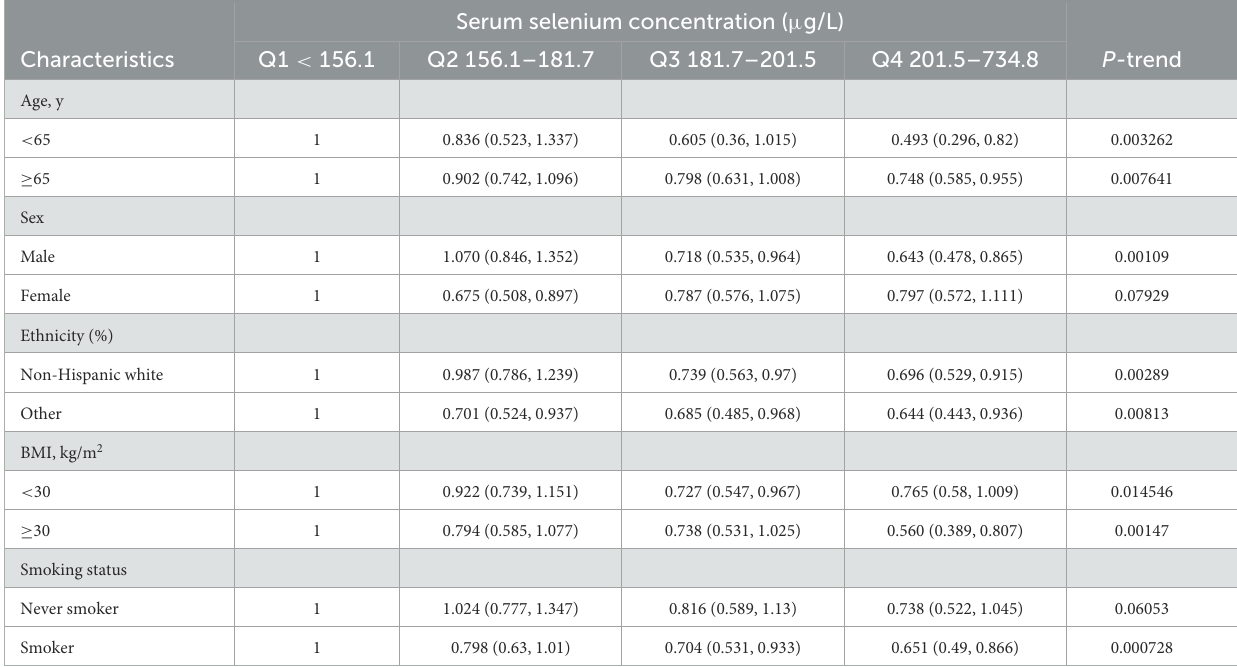
TABLE 4 Subgroup analyses of the associations between serum selenium concentrations and all-cause mortality among CKD patients a .